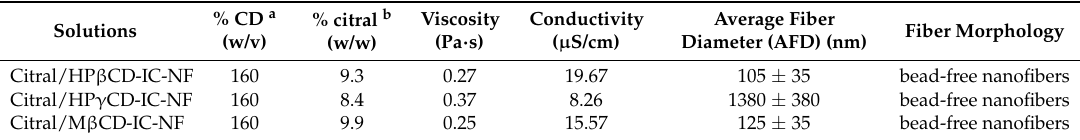
Table 1. The properties of the citral/CD-IC (citral/HP β CD-IC, citral/HP γ CD-IC, citral/M β CD-IC) solutions used for electrospinning and morphological characteristics of the resulting